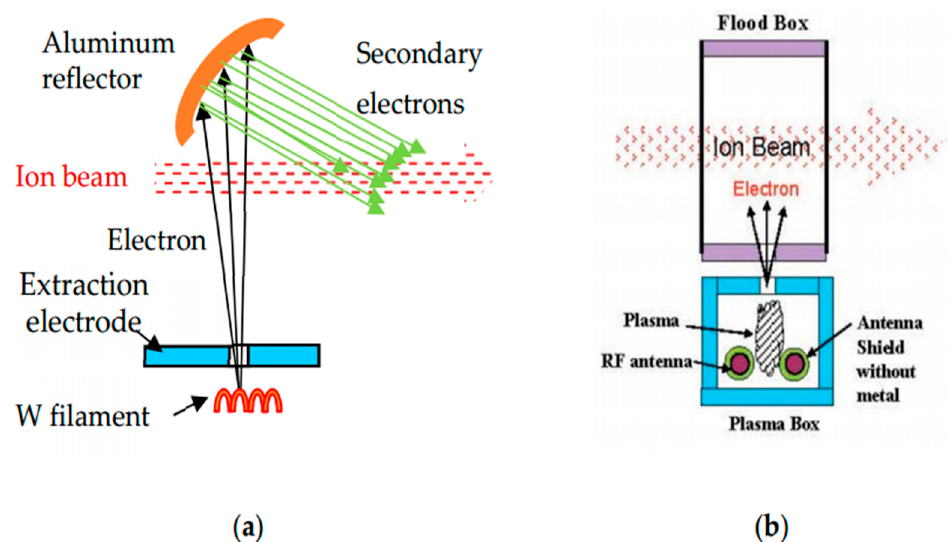
Figure 8. Illustrations of ion beam neutralizer evolution. ( a ) Electron shower; ( b ) plasma shower using RF (radio frequency) plasma generation [17].